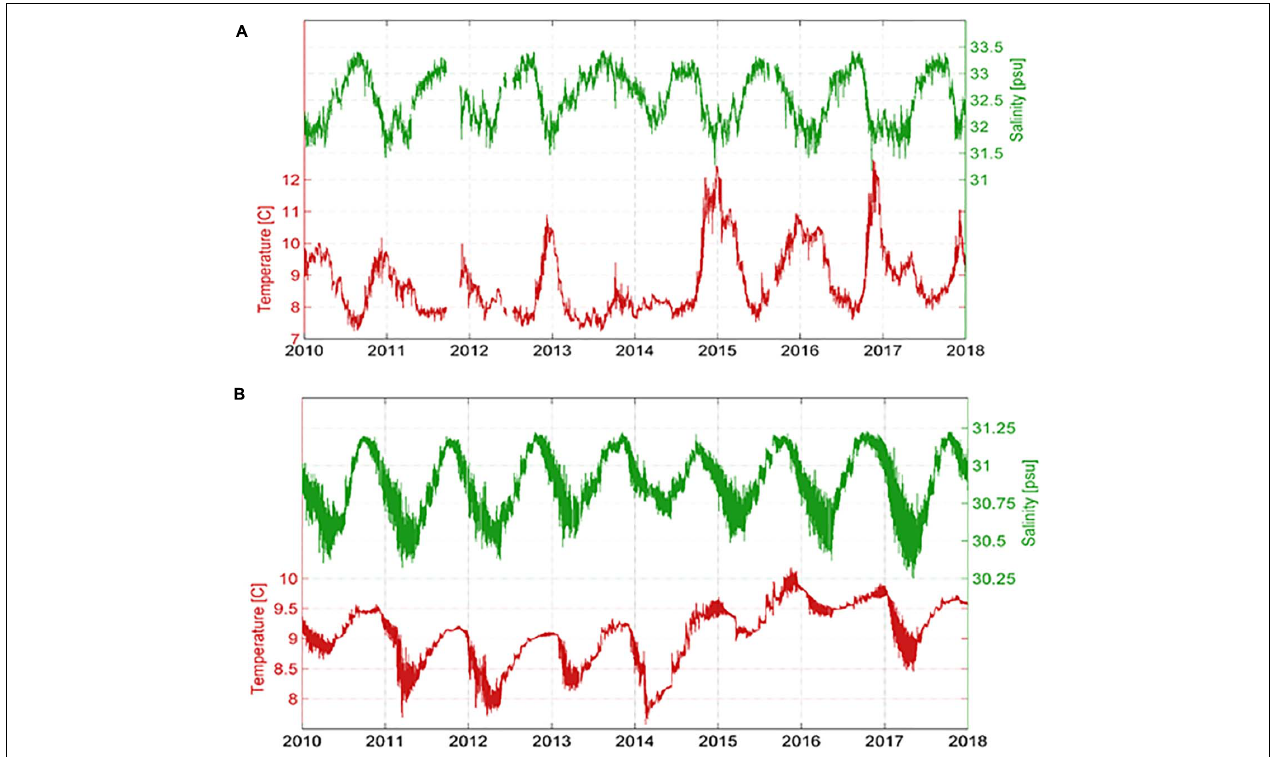
FIGURE 2 | Panel (A) shows NE Pacific temperature and salinity data from Folger Passage (100 m depth off the west coast of Vancouver Island) from 2010 to 2018, recorded by the NEPTUNE cabled observatory of Ocean Networks Canada (ONC) (Ocean Networks Canada Data Archive, 2019a). Panel (B) shows Salish Sea temperature and salinity data from Saanich Inlet (100 m) from 2010 to 2018, recorded by the VENUS cabled observatory of Ocean Networks Canada (Ocean Networks Canada Data Archive, 2019b). Both figures reveal strong annual cycles and abnormally warm conditions persisting throughout 2015–2017.